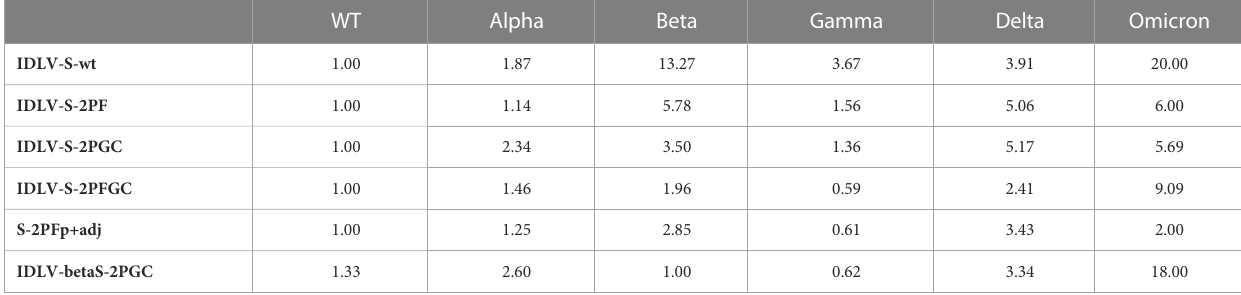
TABLE 2 Median ID50 fold reduction compared to the vaccine strain.